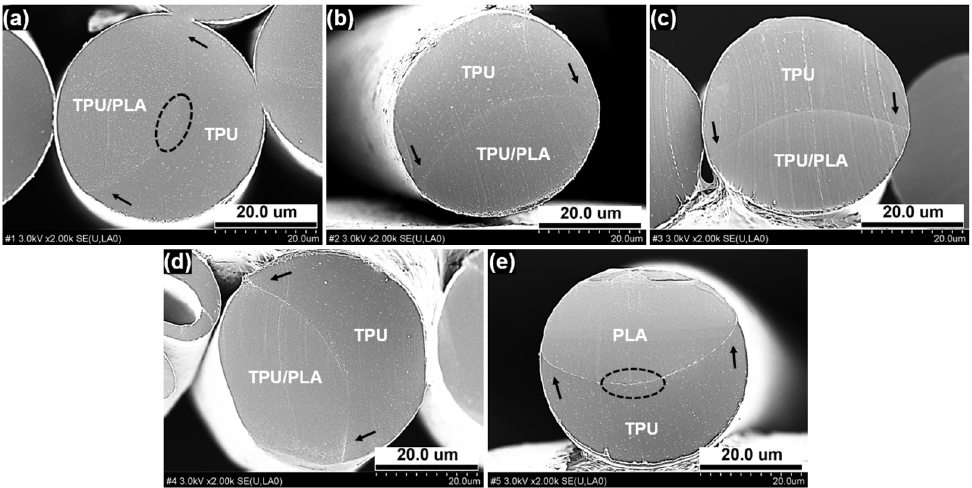
Figure 7. SEM image of TPU/(TPU/PLA), TPU/PLA side-by-side bicomponent fibers cross-section: ( a ) 50/(40/10), ( b ) 50/(30/20), ( c ) 50/(20/30), ( d ) 50/(10/40), and ( e ) 50/50. The arrows visualized the characteristic cross-sectional morphology of the bicomponent fiber.